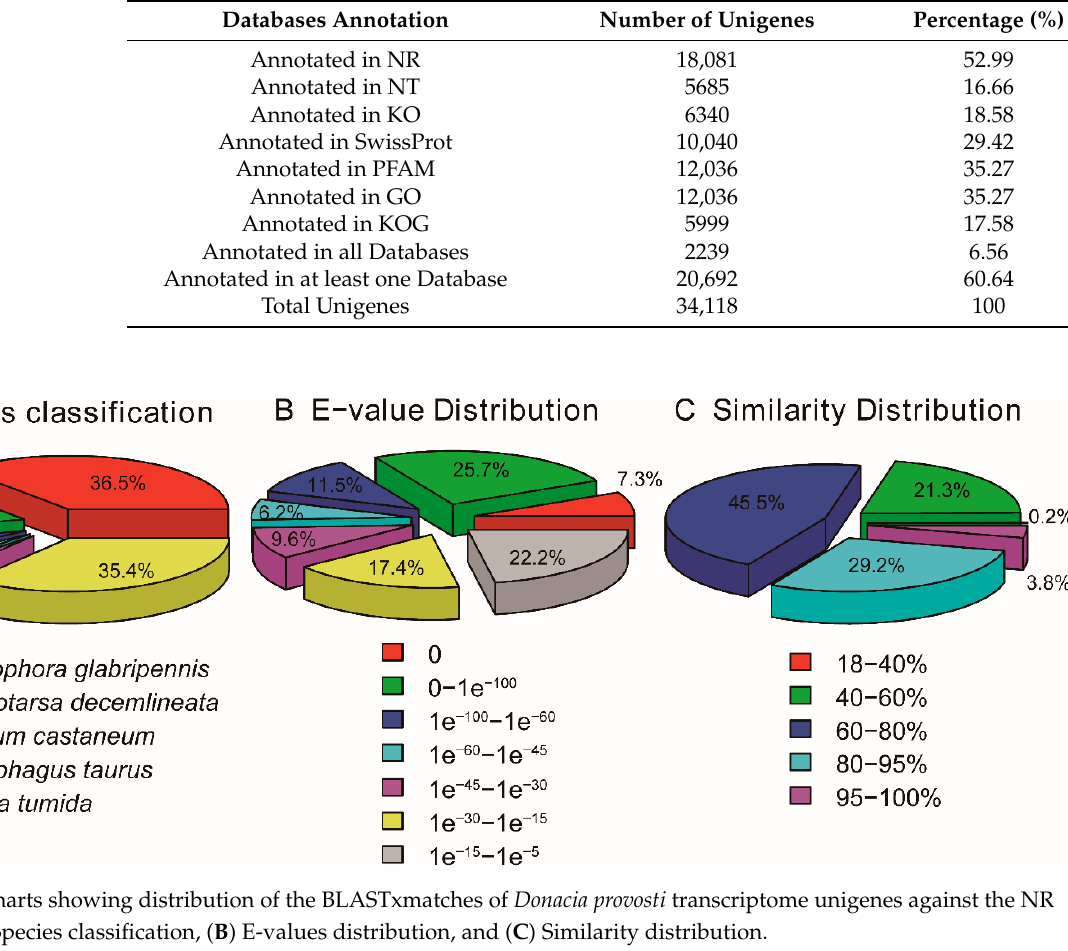
Table 3. Summary of functional annotations of D. provosti unigenes.